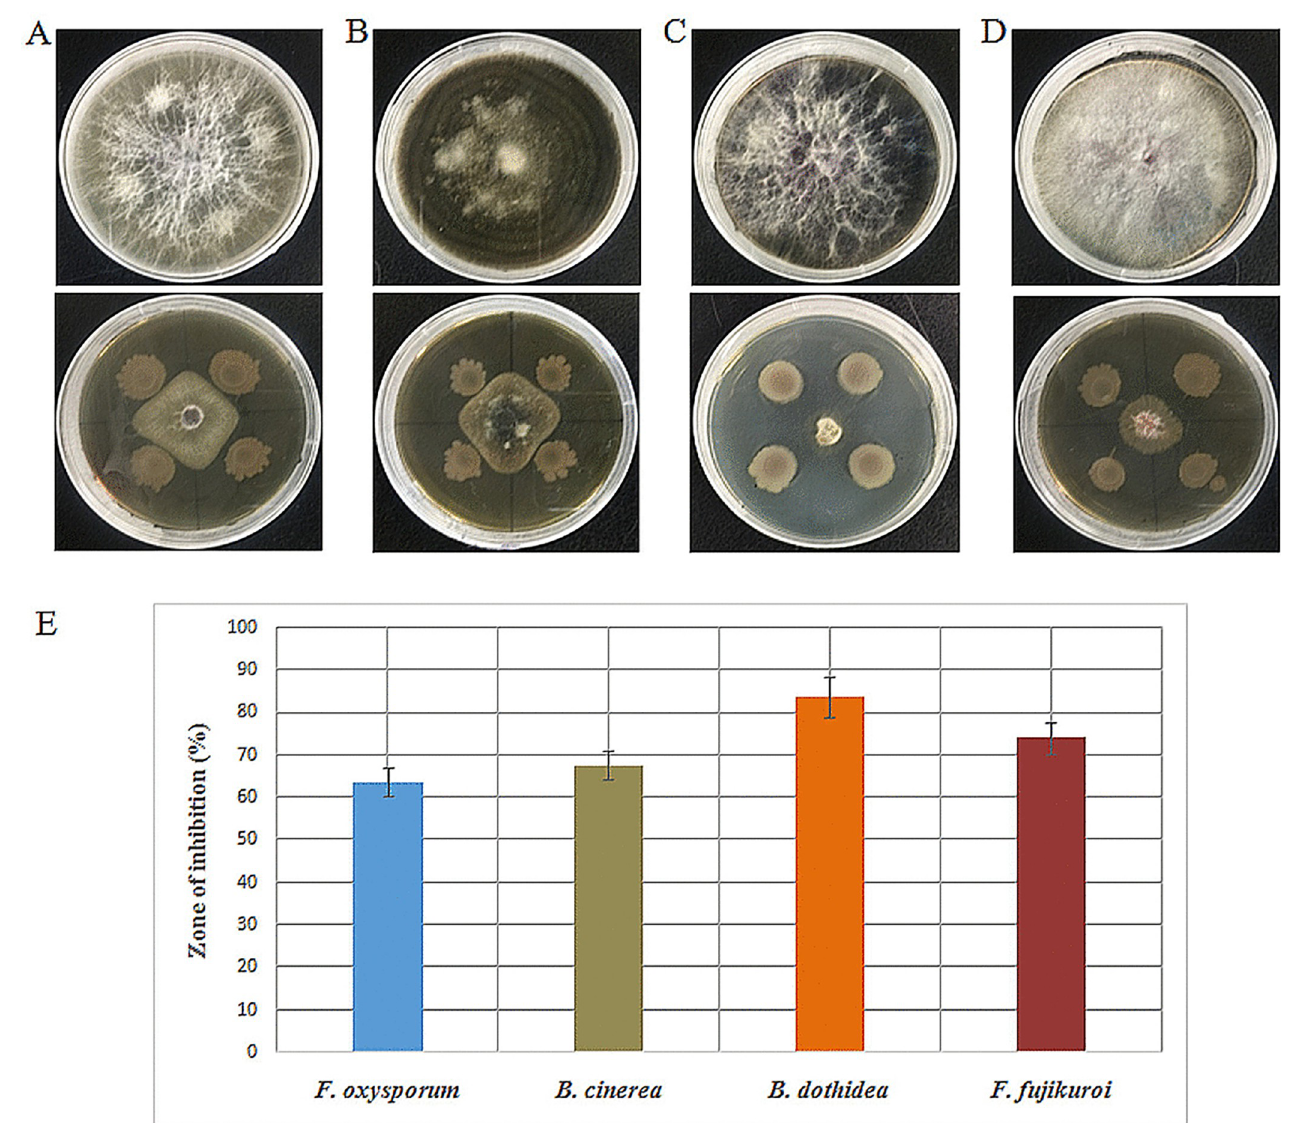
Fig 3. Antifungal activities of the isolated endophytic bacterial strain Ld-08 against fungal pathogens. A 5 mm fungus plug was inoculated into the center of the PDA medium surrounded by four spots of bacterial inoculum. (A), (B), (C), and (D) are control (upper) and test plates (lower) containing dual cultures of Ld-08 and the respective fungal pathogens, F . oxysporum , B . cinerea , B . dothidea , and F . fujikuroi , respectively. (E) antifungal activities were measured as the size of the zones of inhibition of the pathogenic fungi. Zones of inhibitions were expressed as